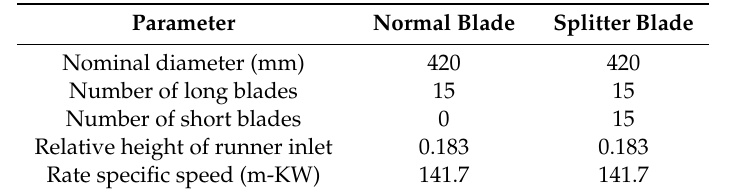
Figure 1. Sketch of two runners: ( a ) runner with splitter blade; ( b ) runner with normal blade. Table 1. Main parameters of two runners.